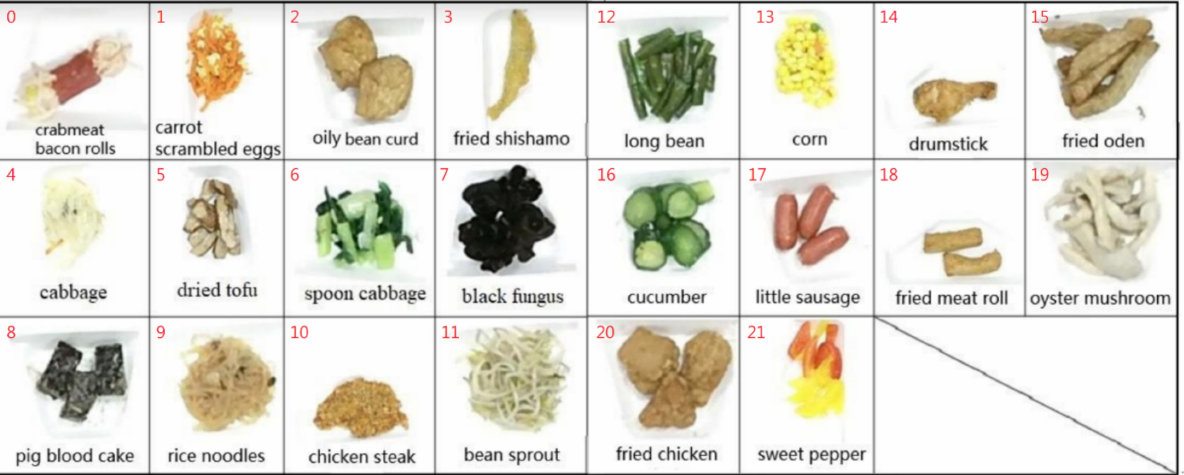
Figure 12. The list of 22 different food items with id numbers in a Bento buffet cafeteria in our experiments.